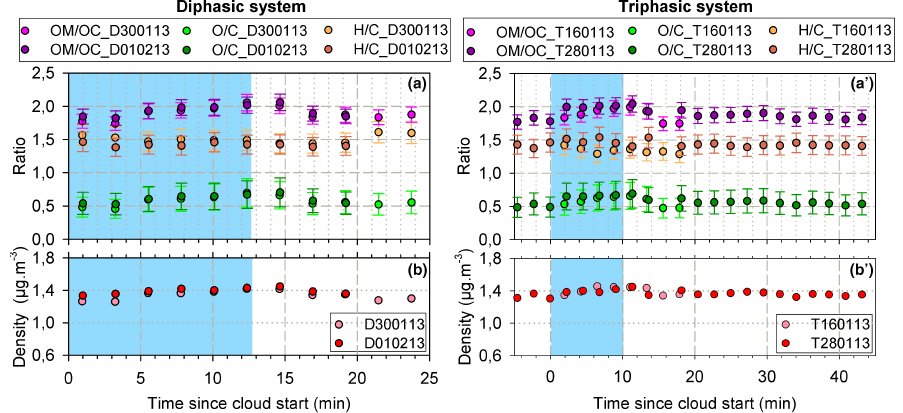
Figure 3. Time profiles of ( a and a’ ) O / C, OM / OC and H / C ratios (with the measurement uncertainty as determined by Aiken et al., 2008), and ( b and b’ ) particle density for diphasic (left panel) and triphasic (right panel) experiments. Blue areas indicate cloud